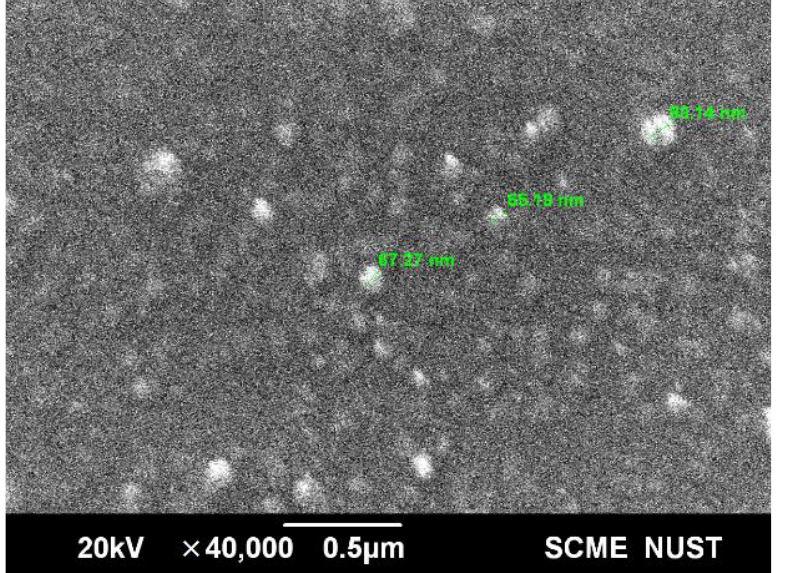
Figure 3. Scanning electron microscopy image of silymarin LNPs, depicting their size and morphol- ogy, using the VEGA3 LMU scanning electron microscope (Tescan, Brno, Czech Republic).